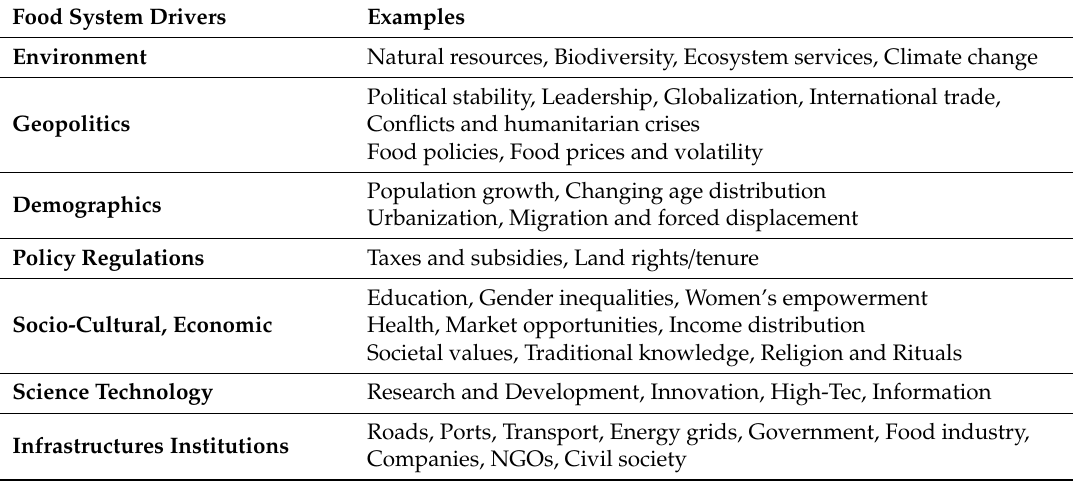
Table 1. The various drivers of Food System Activities.